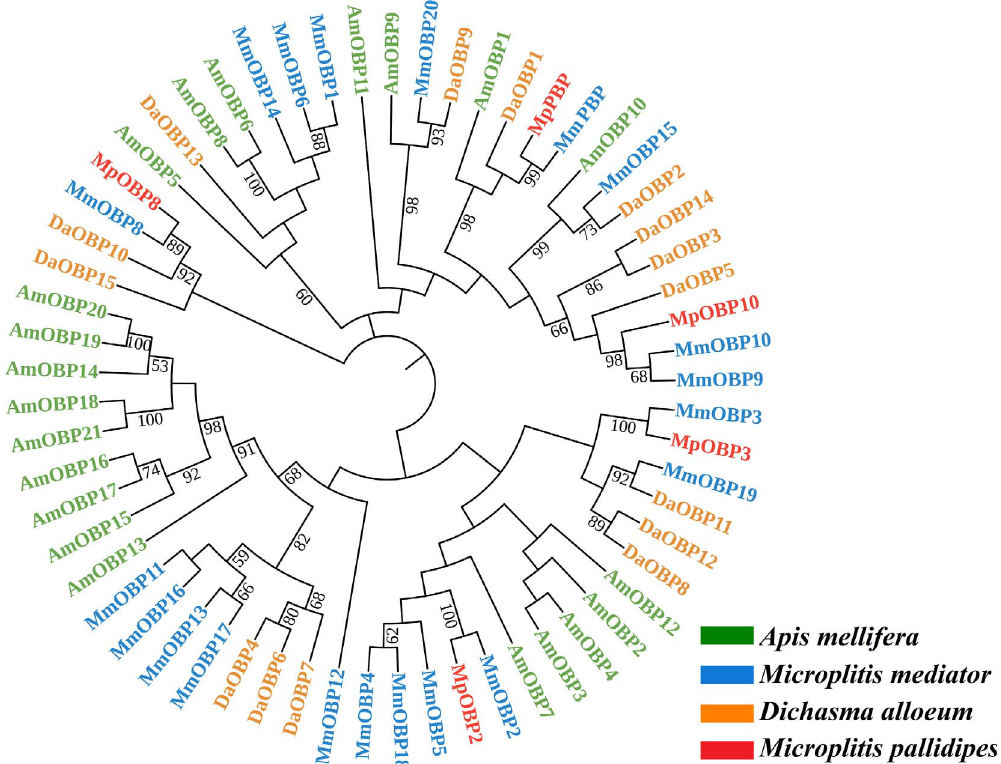
Figure 5. Phylogenetic tree of OBP amino acid sequences reconstructed in MEGA7. Branch lengths indicate evolutionary distances, and numbers represent the tree con fi dence calculated using bootstrap analysis with 1000 replicates. Different colors of text represent OBPs of different species: red, Microplitis pallidipes (Mp); green, Apis mellifera (Am); blue, Microplitis mediator (Mm); yellow, Dichasma alloeum